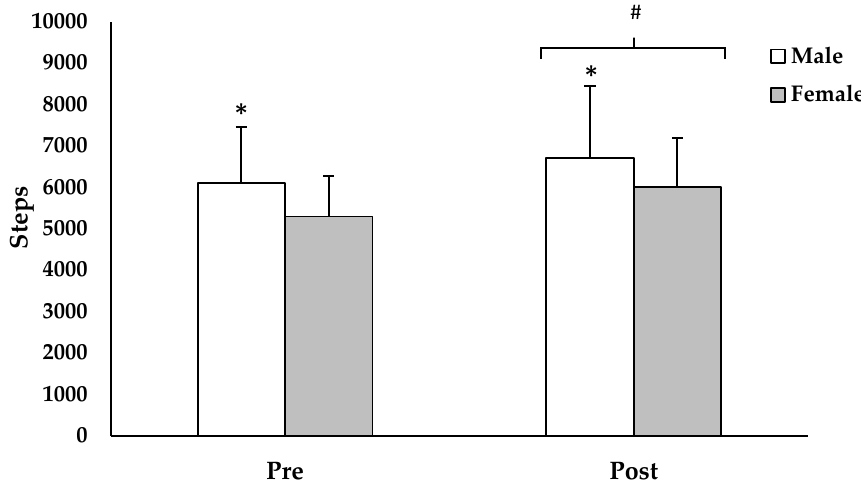
Figure 2. Changes in step count between males and females, following 4 weeks of the TAKE 10! ® curriculum intervention. Values are presented as mean ± SD. * Greater compared to female ( p < 0.001). # Greater compared to pre-intervention ( p < 0.001).